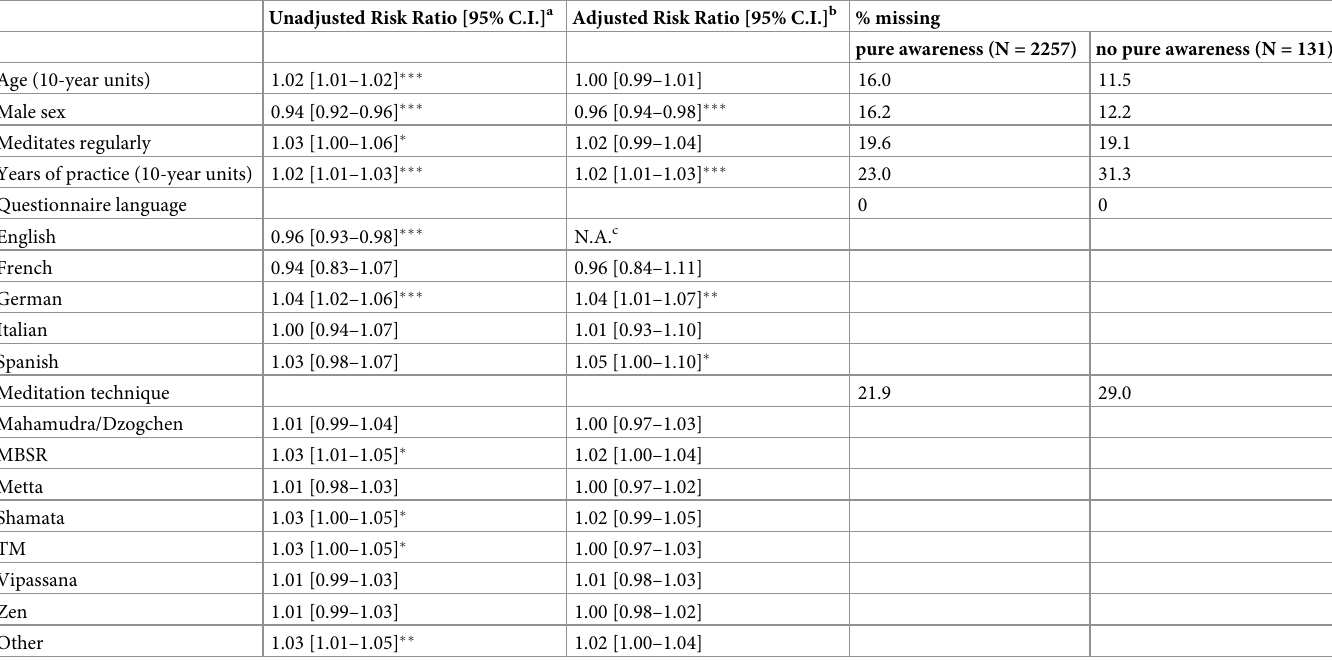
Table 2. Risk ratios comparing participants with (N = 2257) and without (N = 131) an experience of pure awareness.